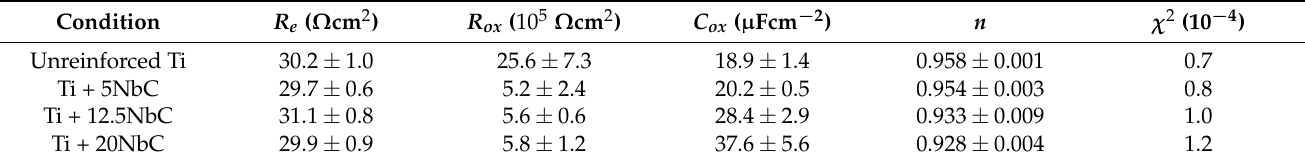
Figure 5. ( a ) Nyquist diagram; ( b ) Bode diagram; ( c ) EEC and definitions for fitting the EIS data. Table 3. Equivalent circuit parameters obtained from EIS data.